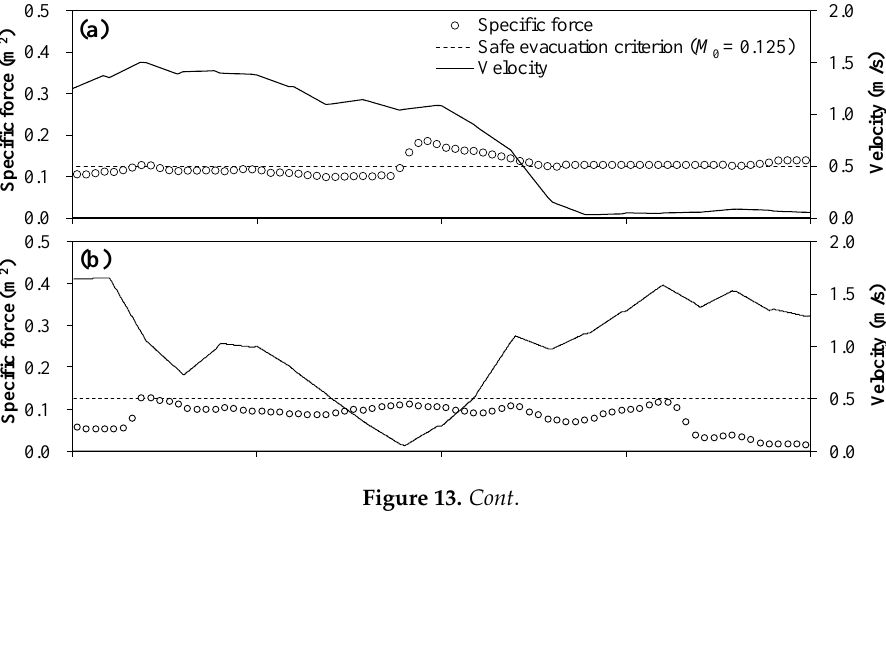
Specific force Safe evacuation criterion (M0=0.125)